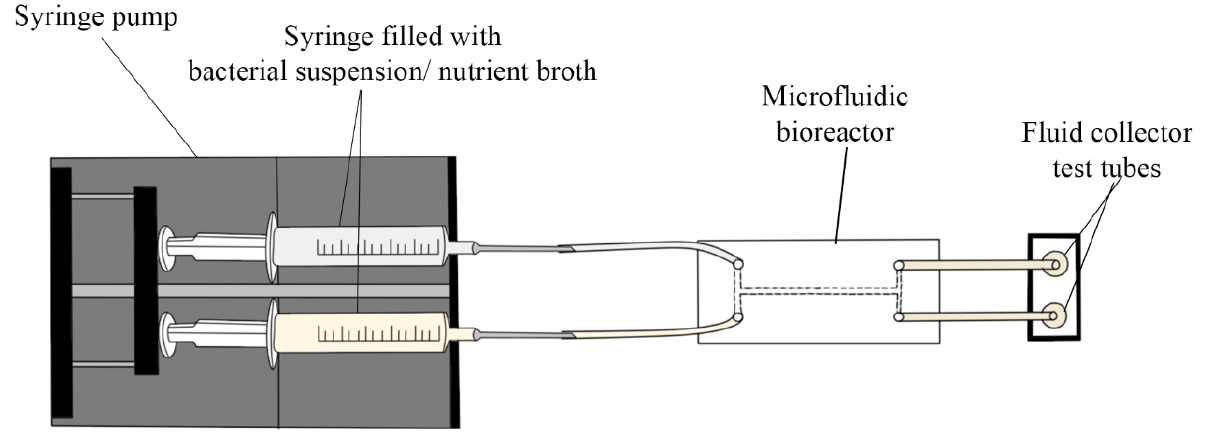
Figure 3. The 3D printed microfluidic bioreactor.